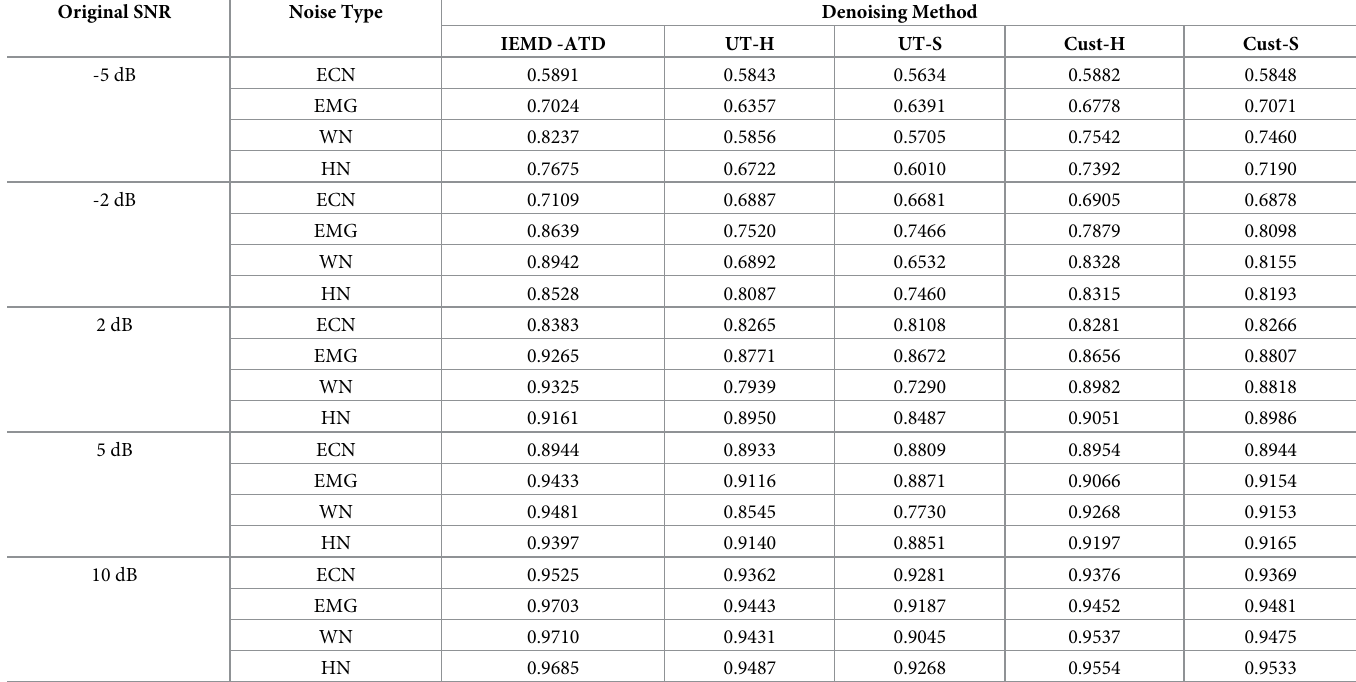
Table 13. Average correlation coefficient of 10 real ECGs.